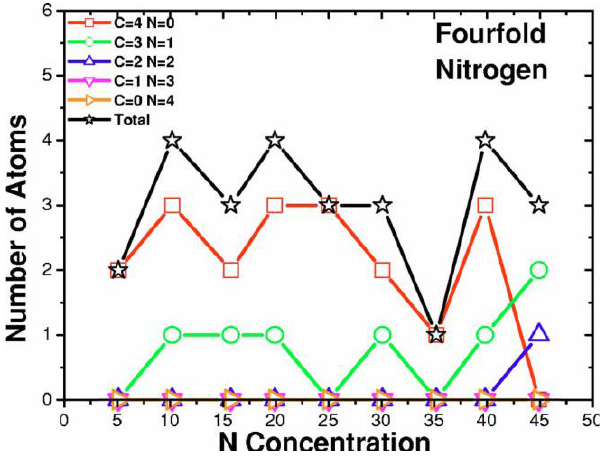
Figure 14. Tetrahedral (dopant) nitrogens are prominent at low concentrations, 0–10%. This behavior is masked by other types of bonding for higher concentrations. Bonding to 4 carbons is represented by squares; to 3 carbons and one nitrogen by